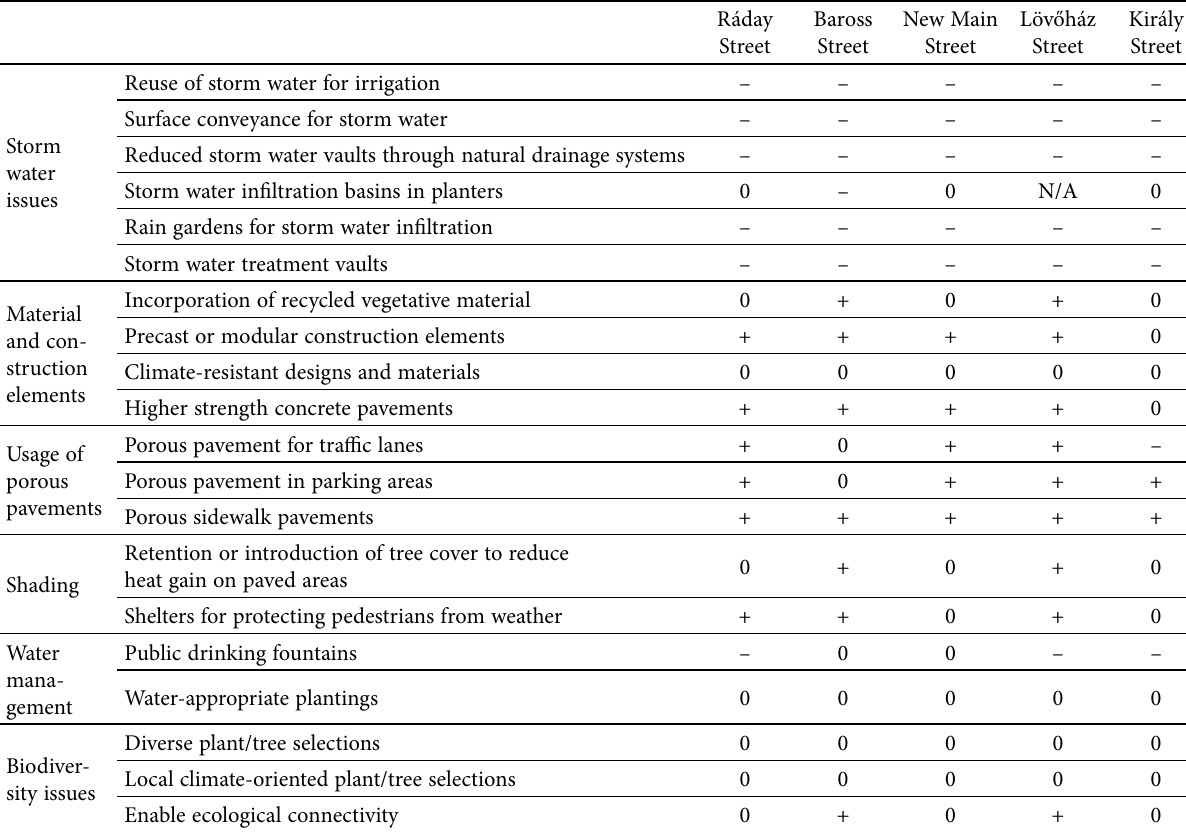
Table 4. Adaptation-centred indicators and results